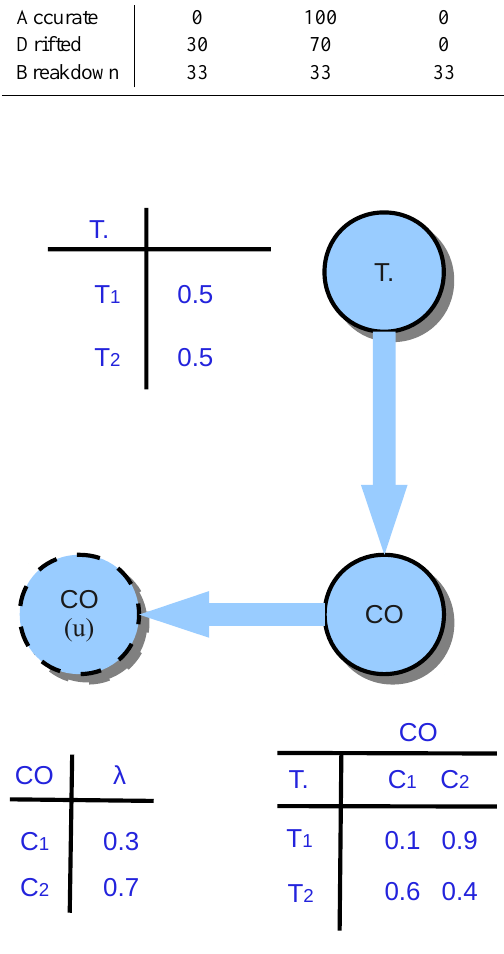
Figure 4. An example of virtual node. (Symbol with ( u ) is referred to the virtual